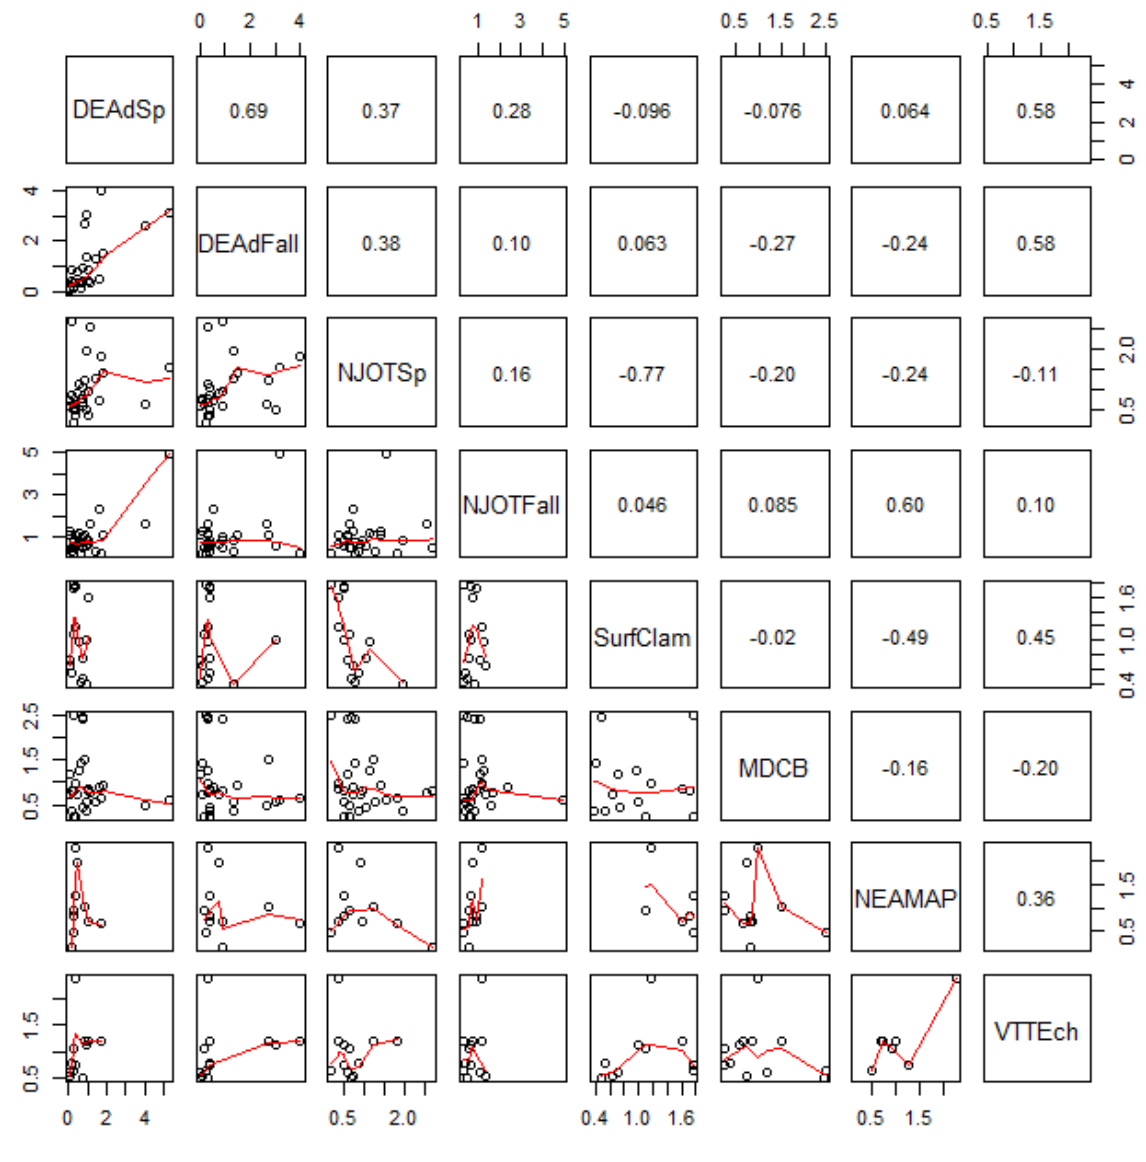
Figure 75. Correlation coefficients and scatter plots for the horseshoe crab abundance indices in the Delaware Bay Region for 1989-2017. All correlations are insignificant ( P >0.05) except for the correlations between the Delaware Adult Trawl spring and fall indices ( P <0.001), Delaware Adult Trawl spring and New Jersey Ocean Trawl fall ( P <0.001), New Jersey Ocean Trawl spring and Surf Clam surveys ( P =0.011), and NEAMAP and the Virginia Tech Trawl ( P